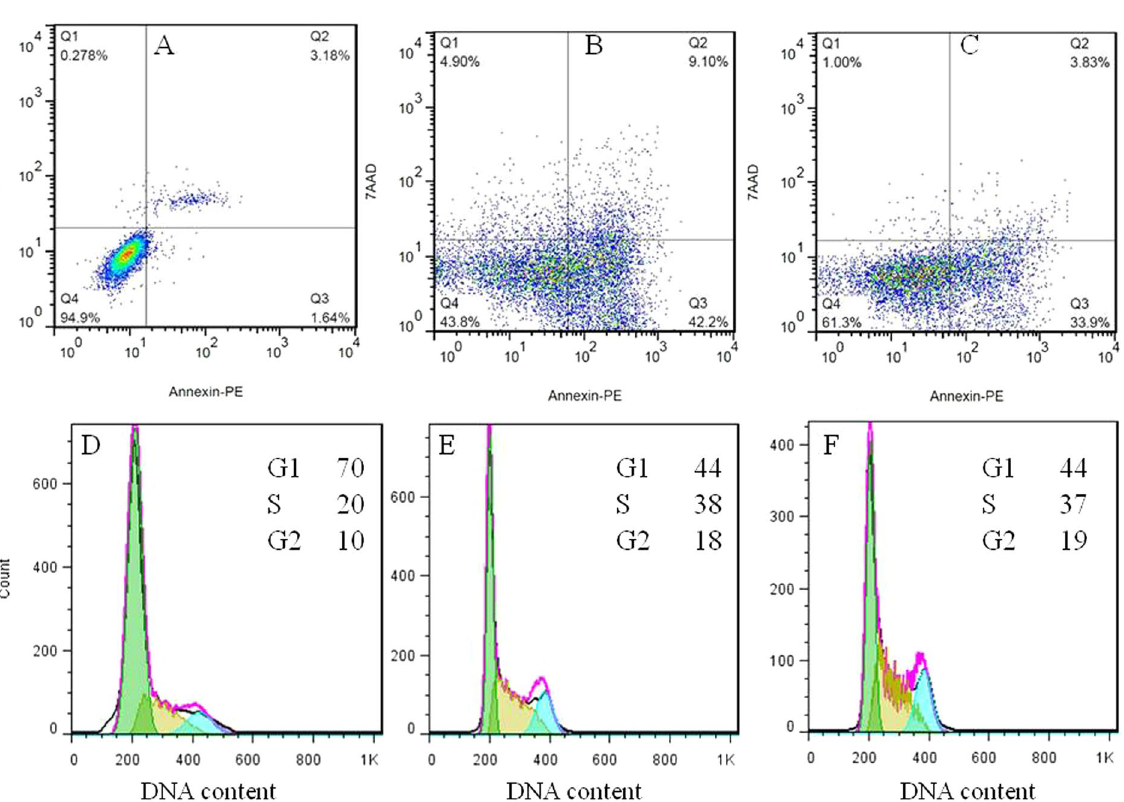
Figure 9. Panels A,B and C represent two-dimensional contour density plots for determination of fractions of early apoptotic, late apoptotic, and necrotic cell death of MDA-MB-231 cells, respectively. Panel A shows the untreated cells as control, while ( B and C ) display the treated cells with LD 50 concentrations of SNPs and ASNPs, respectively, for 24 h. The cell necrosis and apoptosis were measured by using 7-AAD and Annexin-V dyes in flow cytometry based assays. Panels D to F show the effect of ASNPs on the cell cycle. Panel D presents the untreated cells as control, while ( E and F ) show the treated cells with SNPs and ASNPs, respectively. The cells were analyzed by flow cytometry, where the cell count versus DNA content is